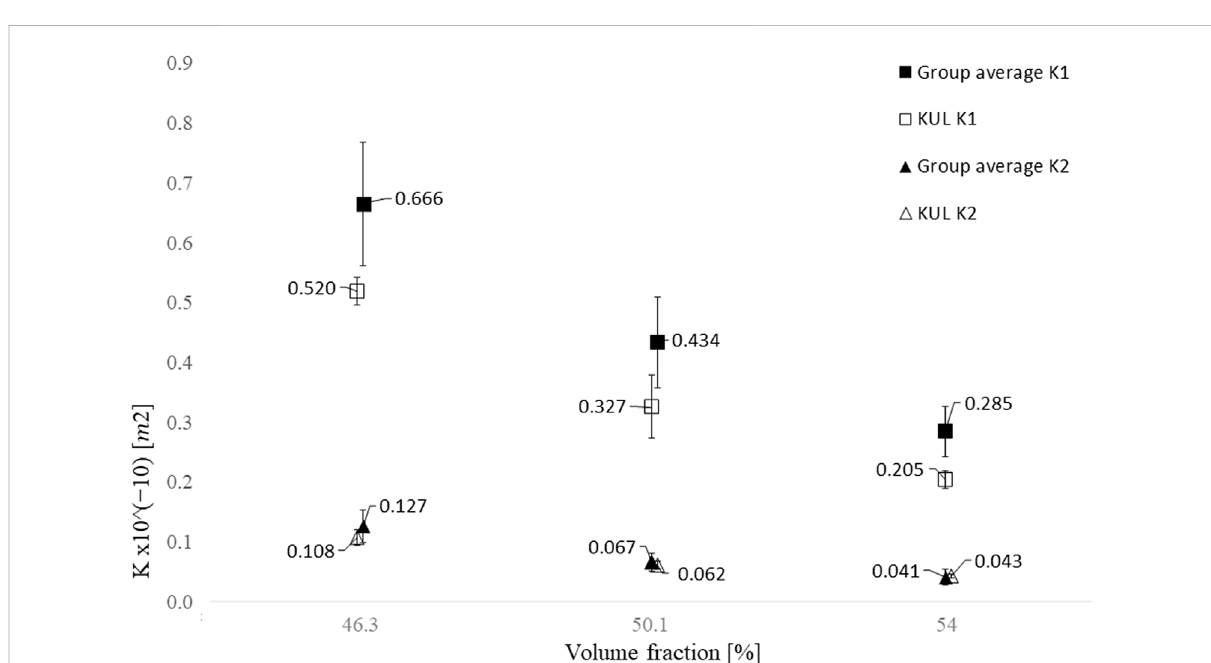
FIGURE 8 Comparison betweentheaverage K 1 and K 2 obtained inthe measurements (KUL)and the group average estimated from thebenchmark results (group average). Before calculating the group average, the results from participants who did not comply with the cavity de fl ection limit of 2%